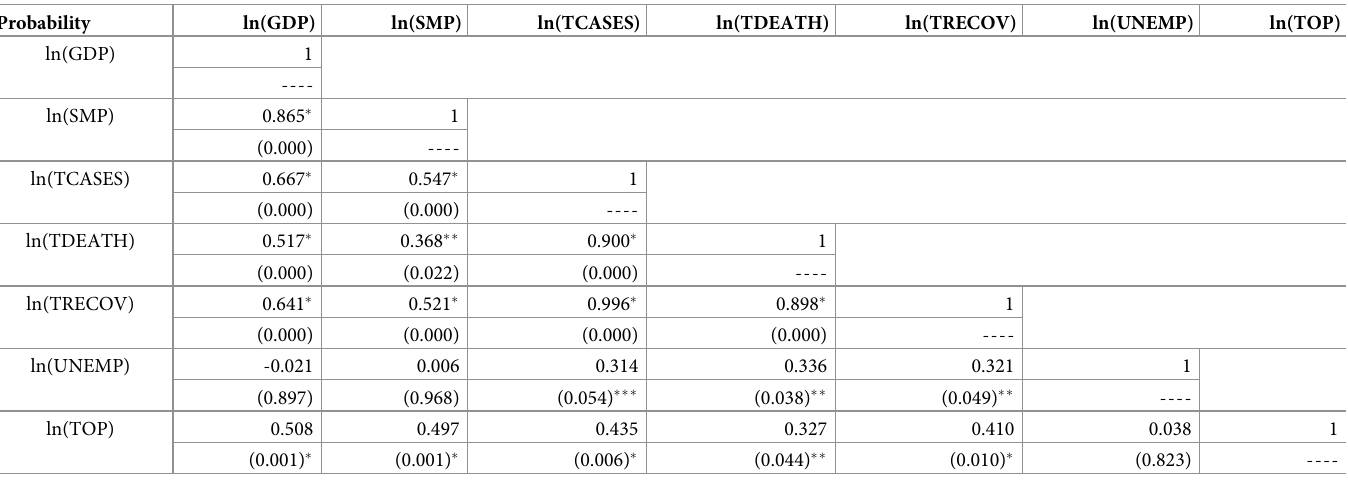
Table 3. Correlation